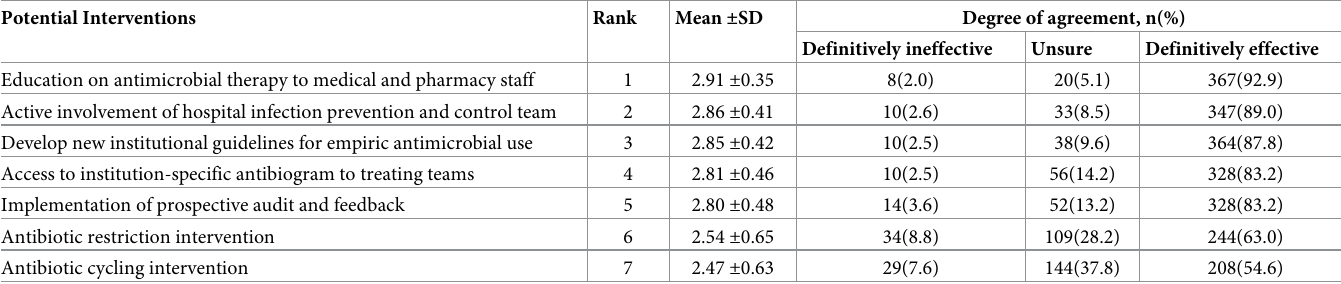
Table 5. Physicians’ and pharmacists’ beliefs on potential intervention to combat AMR at Tikur Anbessa Hospital, Addis Ababa,